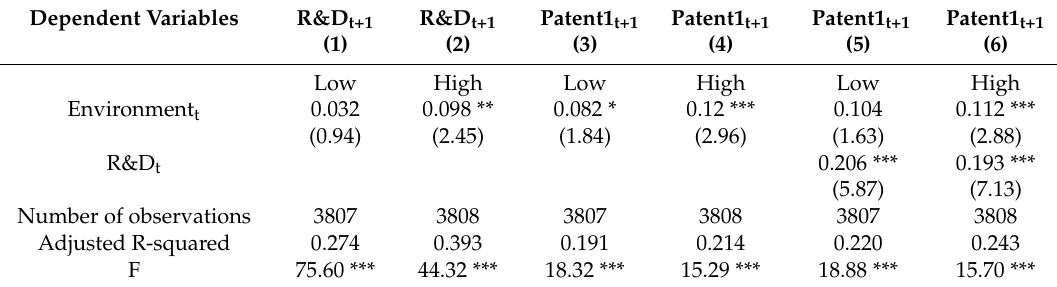
Table 6. The moderating effect of institutional